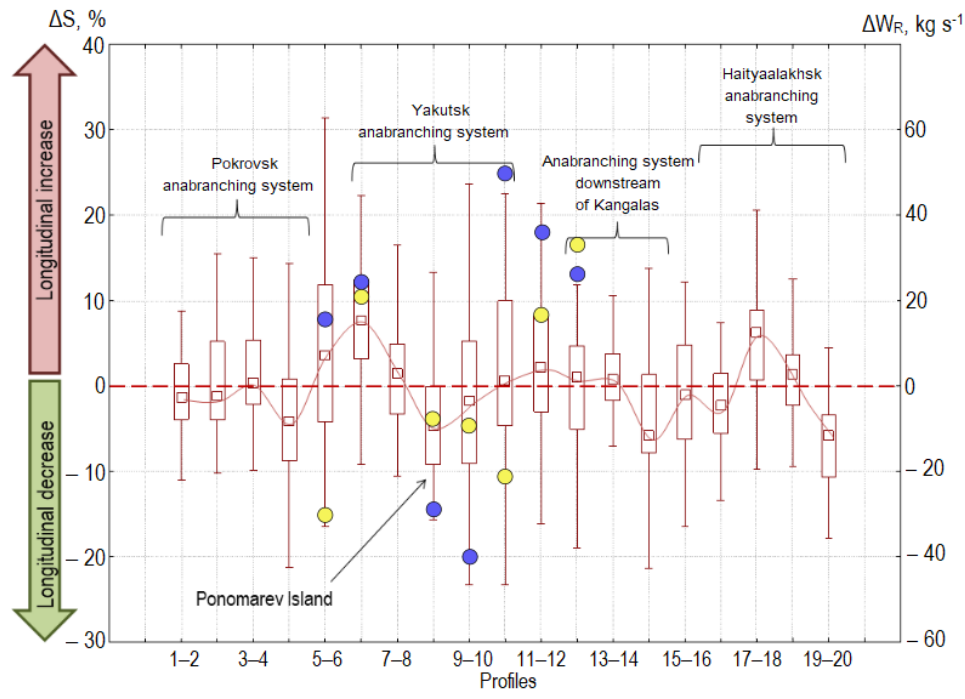
Figure 7. Longitudinal surface SSC changes ( ΔS , %) and sediment load budget ( ΔW R , kg s -1 ) in case study 1 of the Lena River (non-outlier range, mean, STD and 25 – 75%-interval) (profiles in Figure 2). Blue circles represent W R values during the flood-water period, and yellow circles during low-water period.